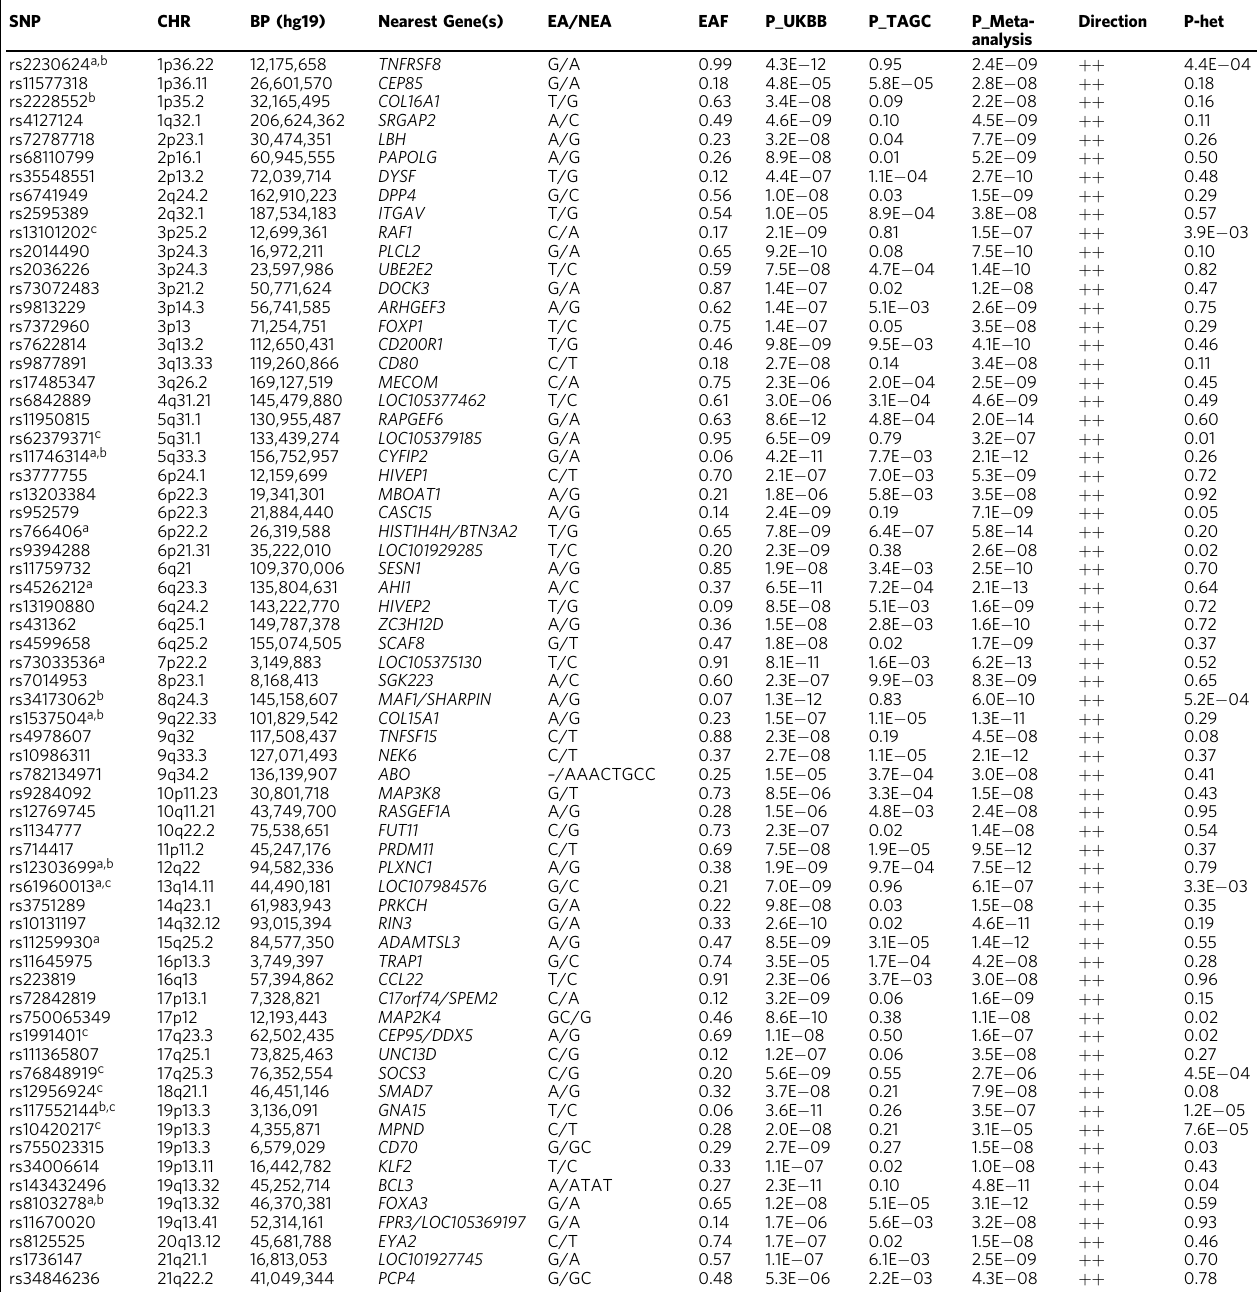
Table 1 66 loci identi fi ed for asthma in meta-analysis of the UK Biobank and TAGC. SNP CHR Nearest Gene(s) rs2230624